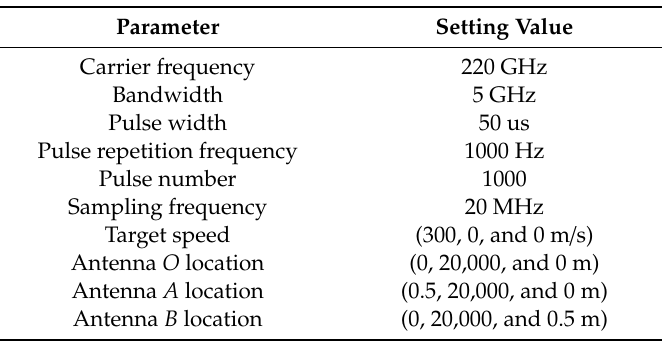
Table 1. Parameter settings of the radar system and target.